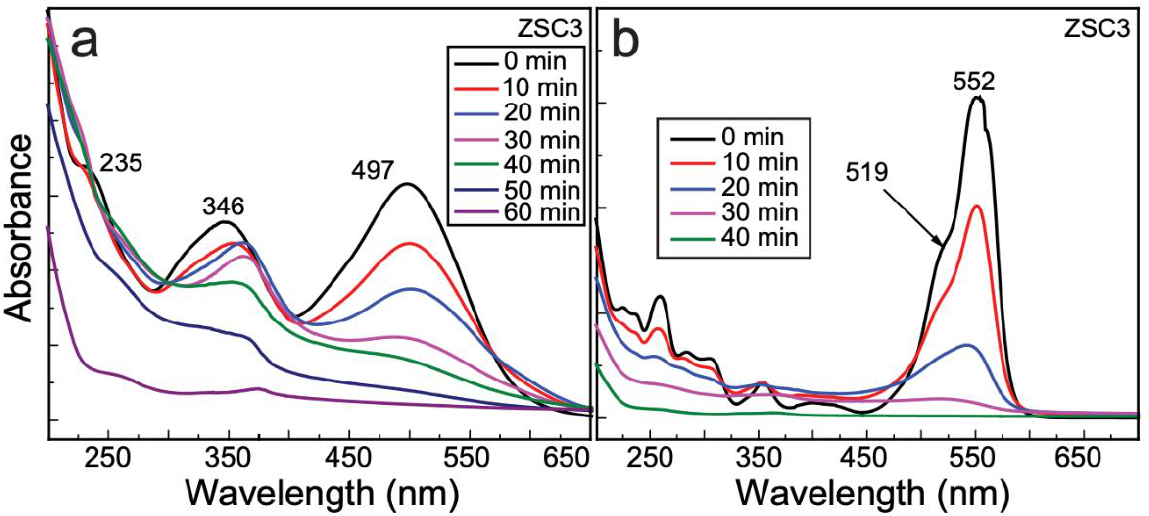
Figure 10. The photocatalytic degradation of dyes ( a ) Congo red and ( b ) rhodamine B by the ZSC3 nanocomposite.